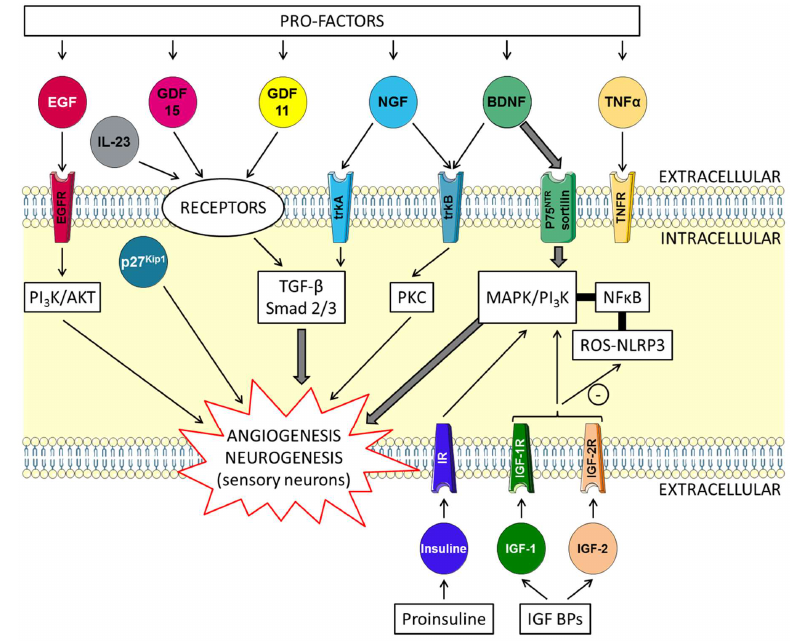
Figure 1. Neurotrophins and their effect on angiogenesis and neurogenesis in the skin. Brain-derived neurotrophic factor (BDNF) binds to two receptors—tropomyosin receptor kinase B (trkB) or the neurotrophin receptor, p75 NTR . BDNF preferentially binds to a P75 NTR -sortilin complex. TrkB can activate various intracellular pathways, such as the protein kinase C (PKC). Nerve growth factor (NGF), growth differentiation factor-11 (GDF11) and growth differentiation factor-15 (GDF15) act on neurogenesis and angiogenesis through the TGF-β/Smad2/3 signaling pathway. Insulin and insulin-like GFs (IGFs) bind to membrane receptors: type I (IGF-1R), type II (IGF-2R), insulin receptor (IR) targeting MAPK and PI3K. Bioavailability of the IGFs is regulated by specific binding proteins (IGFBPs). IGFs affect multiple signaling cascades through reactive oxygen species (ROS) metabolism and the critical regulator of inflammation NLRP3. P27 Kip1 is a key regulator of cell growth arrest and IL-23 expression in keratinocytes is associated with inflammation. Epidermal growth factor receptor (EGFR) and its ligands (EGFR) stimulate the AKT/PI3K pathway. Tumor necrosis factor-α (TNF-α) induces activation of the nuclear factor-kappa B (NF-κB) signaling pathway limited by GDF11. The group of neurotrophins includes various growth factors such as nerve growth factor (NGF) and BDNF. Each of these molecules has a prodomain that is cleaved to yield the mature isoform. Many stimuli, such as hormones, exert temporal control over BDNF transcription. Two receptors have been identified for BDNF: tropomyosin receptor kinase B (trkB) and the common neurotrophin receptor, p75NTR. The mature form of BDNF preferentially binds to trkB, resulting in pro-growth signaling. However, proBDNF preferentially binds p75NTR, resulting in antigrowth signaling. The two receptors for BDNF have opposing roles and maintain a balance between growth and death. BDNF binds to a p75NTR-sortilin complex. As a neurotrophin, BDNF has emerged as an important regulator of axon regeneration in skin. p75NTR, the receptor for BDNF, is expressed in sensory neurons. After skin injury, sensory neurons decreased expression of p75NTR, which could act as a survival signal [24]. Recent results show some relationship between BDNF and other factors such as